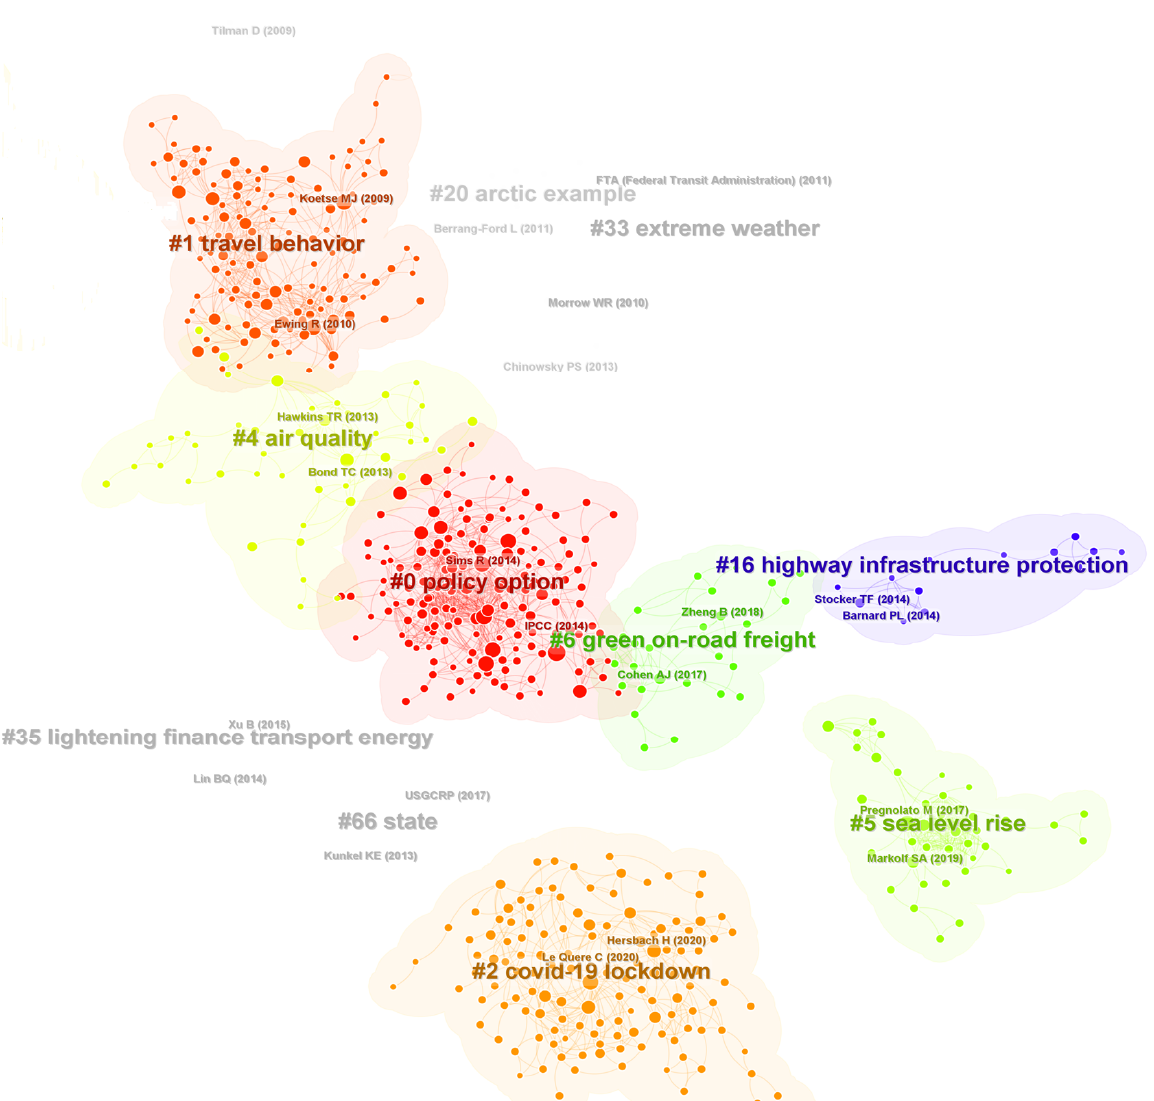
Figure 6. Reference co-citation network.